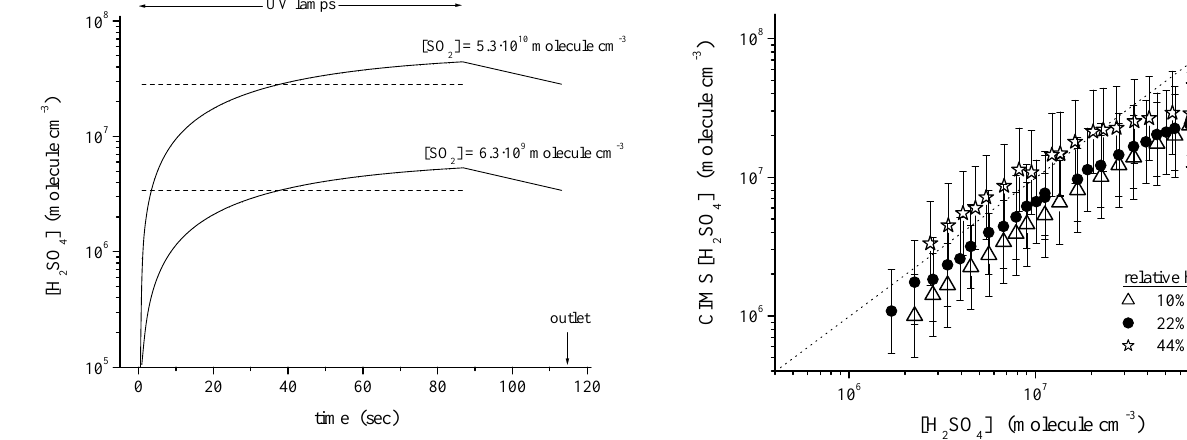
Fig. 2. Comparison of measured [H 2 SO 4 ] with modelling results for [H 2 SO 4 ] for 3 different relative humitities. The dashed line shows the 1:1 line. The total flow in IfT -LFT was set at 11lmin − 1 (residence time in irradiated middle section of 88s). Initial reac- tant concentrations are (unit:moleculecm − 3 ); O 3 : 3.4 × 10 11 ; SO 2 : (0.32–23) × 10 10 ; CO: 2.1 × 10 14 . count (length: 97 cm, H 2 SO 4 loss: 41%). Error bars